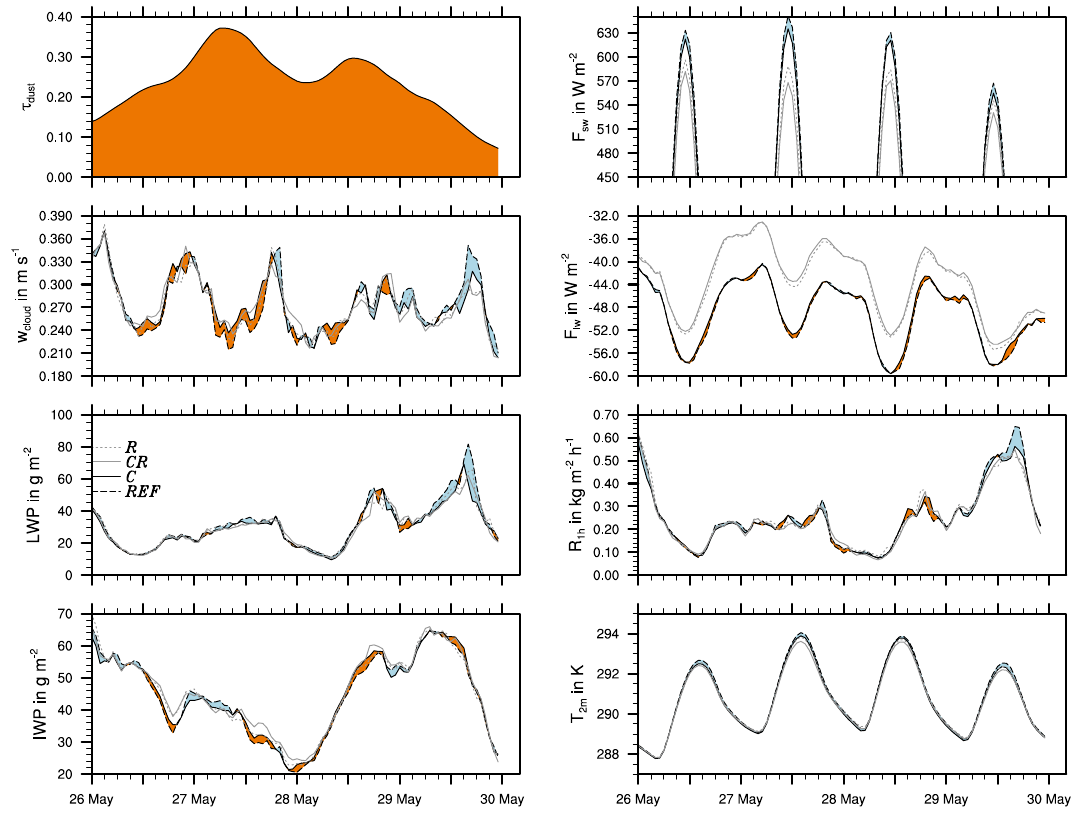
Fig. 13. Time series of dust optical thickness ( τ dust ), cloud properties ( w cloud , LWP, and IWP), precipitation rate ( R 1h ), net surface radiation fluxes ( F sw and F lw ), and temperature ( T 2m ) averaged for domain D1. Solid lines are results from simulation C, dashed lines are results from simulation REF, solid gray lines are results from simulation CR, and dotted gray lines from simulation